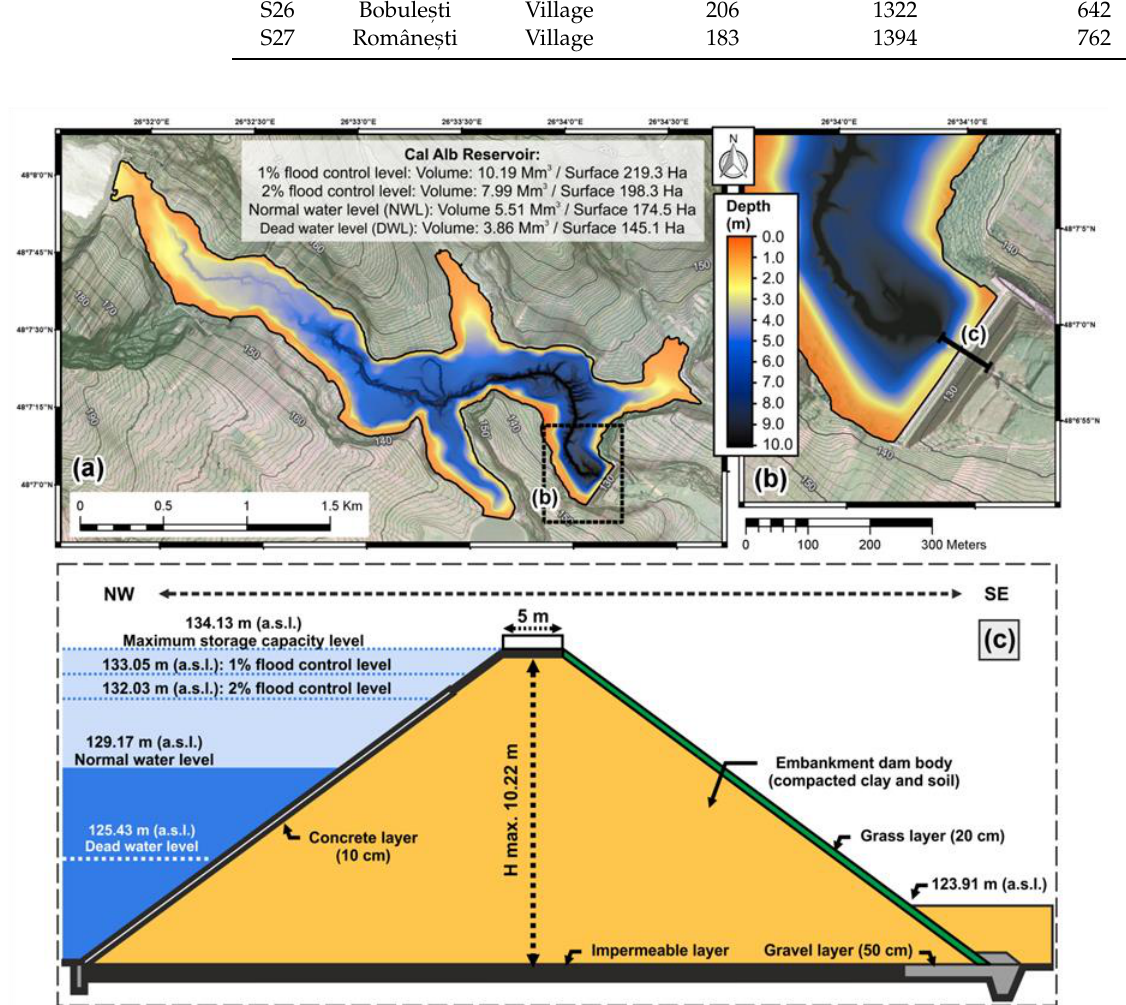
Figure 2. ( a ) The bathymetric model of Cal Alb (R1) reservoir (0.5 m spatial resolution) and volume and surface characteris- tics at dead water level (DWL), normal water level (NWL), and the flood control level for 1% and 2% recurrence intervals; ( b ) R1 dam area; ( c ) cross-section sketch of R1 embankment dam body. Table 1. Characteristics of the main dams within Bașeu river basin according to Romanian National Classification (RNC) [51]. Reservoir Dam